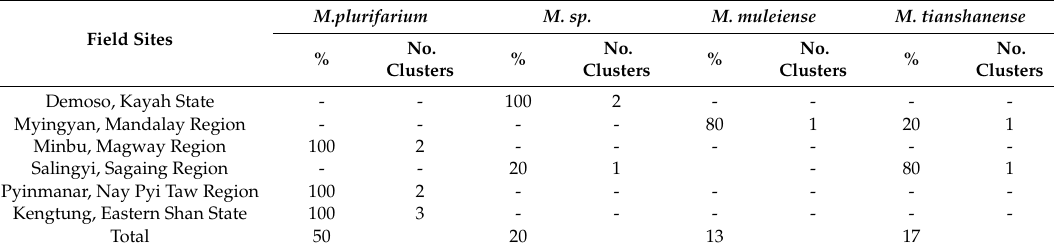
Table 4. Percentage distribution (%) of isolates at each field